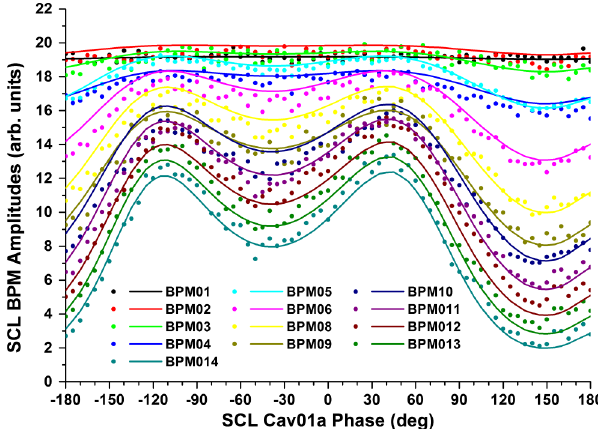
FIG. 3. The amplitudes of all 13 BPMs in the SCL as a function of the first SCL cavity phase. Points are measured values, and the curves are from the model.